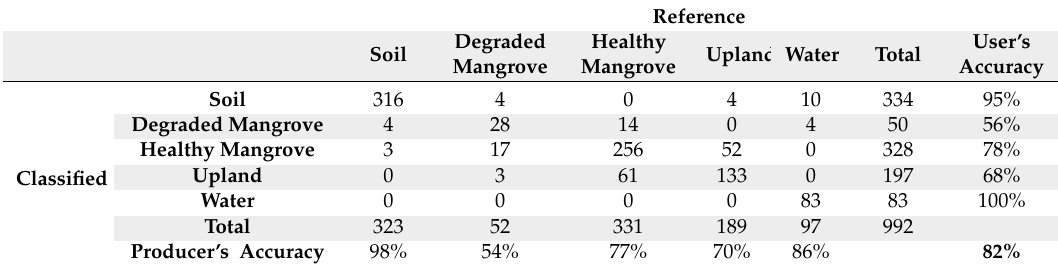
Table 2. Confusion matrix for decision tree (DT) classifier results for the fall 2018 map mosaic indicating the number of ground reference points (GRPs) classified correctly or incorrectly. Overall accuracy in bold (Kappa = 0.757).